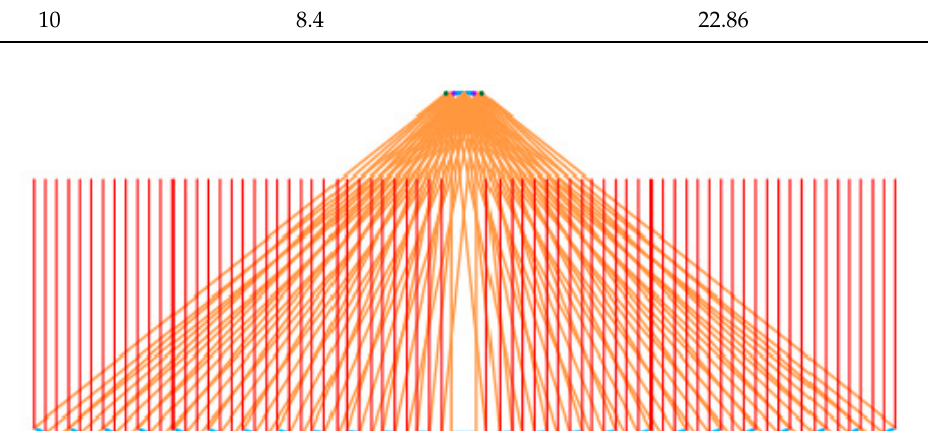
Figure 7. Arrangement of the Fresnel reflector mirrors. Table 2. Position of the primary mirrors at solar noon ( ω (cid:3404) 0 ; Γ (cid:3404) 0.5753 ).